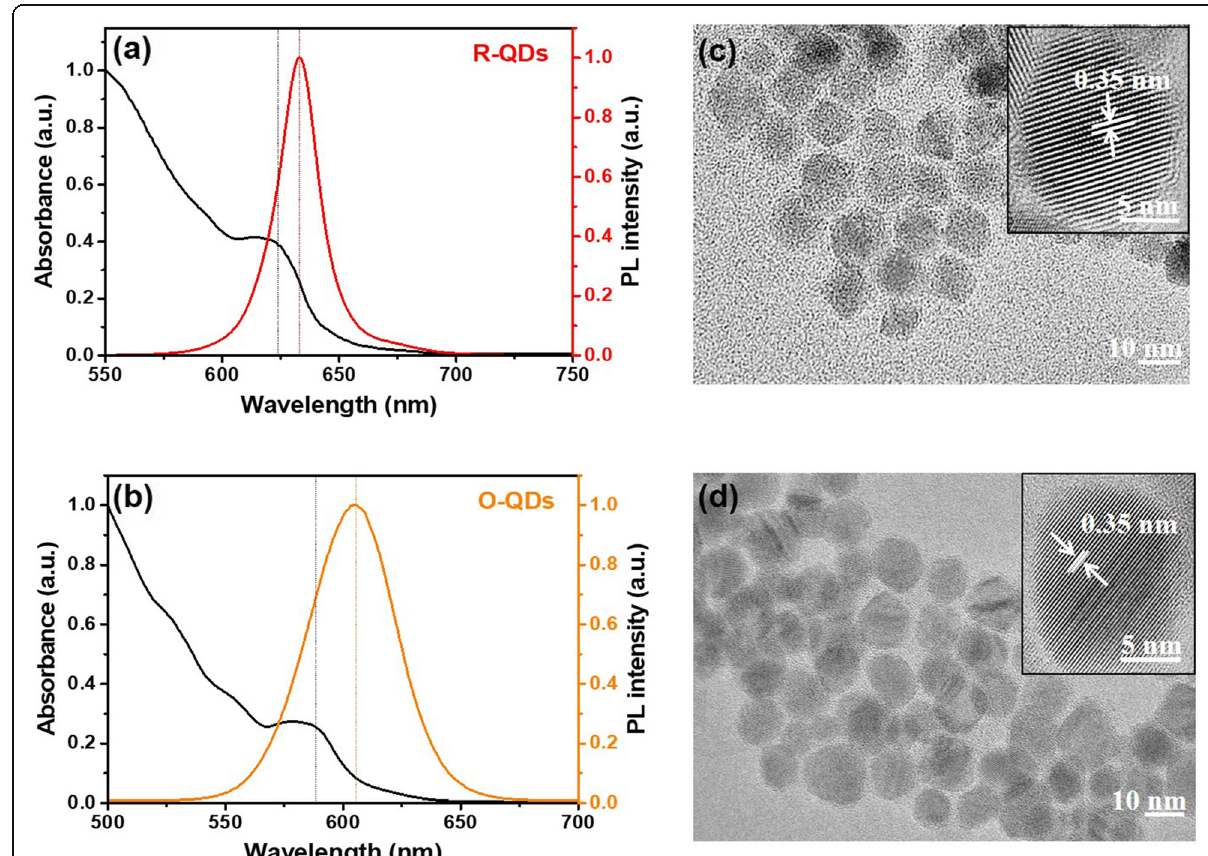
Fig. 1 PL and UV spectra of R-QDs ( a ) and O-QDs ( b ). TEM images of R-QDs ( c ) and O-QDs ( d